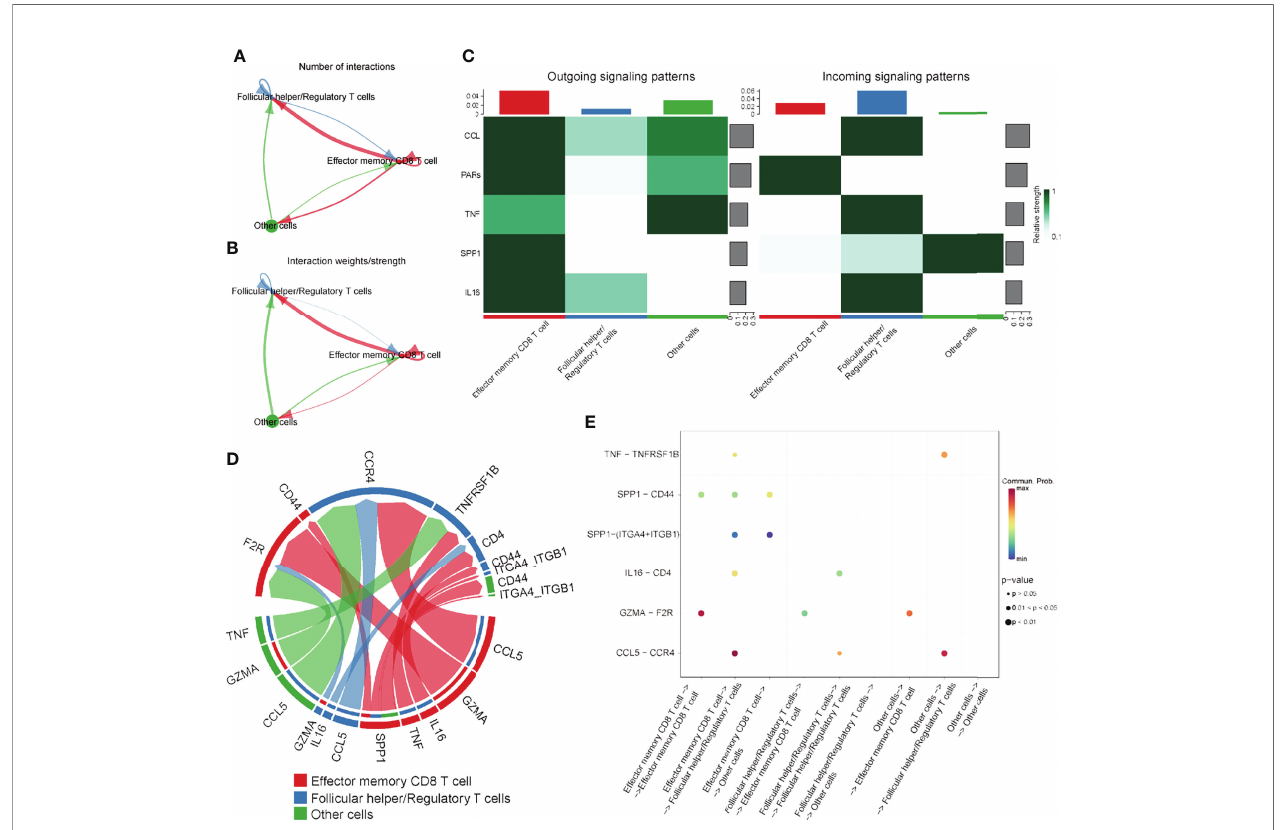
FIGURE 6 | The results of cell-cell communication analysis. (A) Number of interactions among immune cells. (B) Strength of the interactions among the immune cells. (C) Heatmap visualizing the possible incoming or outgoing signaling pathways among the immune cells. (D, E) Chord diagram or dot plot visualizing the possible incoming or outgoing signaling